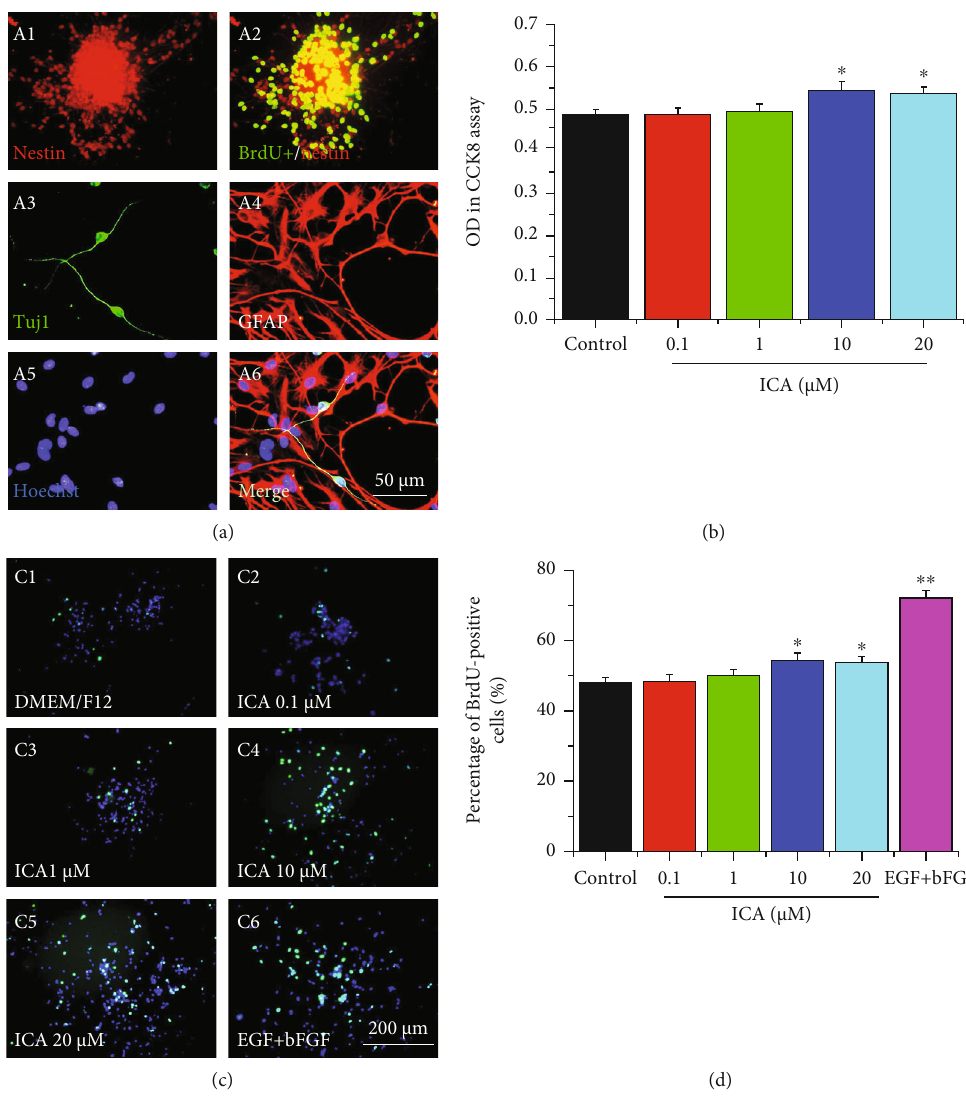
Figure 2: Identi fi cation of NSCs isolated from embryonic day 14 rats and bene fi cial e ff ects of ICA on the survival and proliferation of NSCs in vitro . (a) Representative images of nestin-positive cells (A1, green) and BrdU-positive cells (A2, red) in a neurosphere. After di ff erentiation, NSCs were immunoreactive to neuron marker Tuj1 (A3, green) and astrocyte marker GFAP (A4, red). Hoechst (A5) and Merge (A6). Scale bar = 50 μ m . (b) The optical density of NSCs treated with di ff erent concentrations of ICA as measured by cell-count kit-8 (CCK-8) assay, n = 6 . (c) Immunostaining of BrdU-labelled NSCs under di ff erent proliferation mediums (C1: basic DMEM/F12 medium; C2-5: basic medium with ICA at 0.1, 1, 10, and 20 μ M; C6: basic medium with EGF 20ng/ml and bEGF 20 ng/ml), scale bar = 200 μ m . (d) Quantitative analysis of the percentage of BrdU-positive cells. Data are expressed as the mean ± SEM , n = 25 . ∗ P < 0 : 05 and ∗∗ P < 0 : 01 , drug-treated groups vs the control